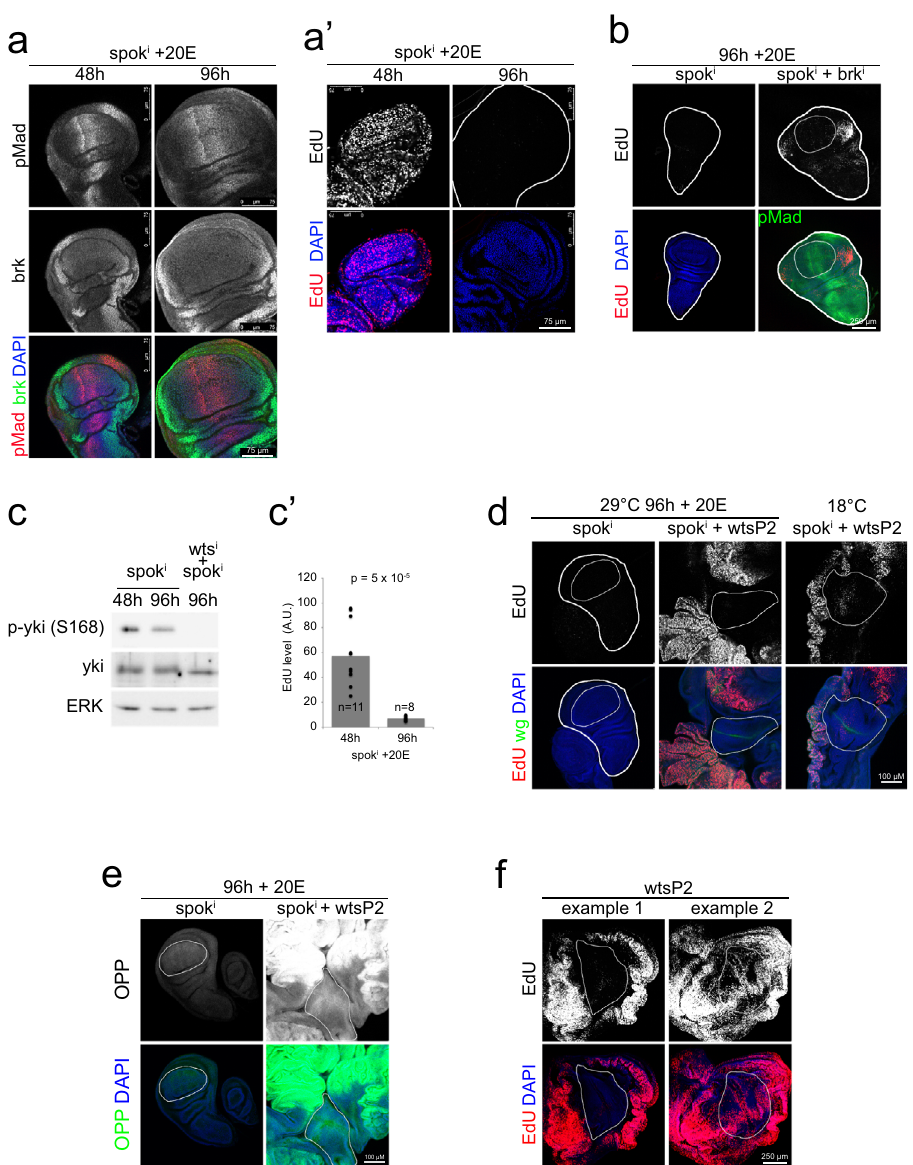
Fig. 3 For a given ecdysone concentration, proliferation in the wing pouch terminates successfully in the absence of warts or brinker . a – a ’ Dpp signaling activity, assayed by immunostaining Tub ts > spok i + 20E discs with pMad and brk antibodies ( a ), is similar in proliferating discs and in discs that have terminated proliferation ( a ’ ), 48 and 96 h after knockdown induction, respectively. Proliferation was assayed by EdU incorporation. n = 10 discs/condition × 3 biological replicates. b The wing pouch terminates proliferation also upon knockdown of brk . 96 h after knockdown induction, Tub ts > spok i + 20E discs have terminated proliferation, assayed by EdU incorporation. Most regions of discs with concomitant knockdown of brk ( spok i + brk i ) also stop proliferating with only the very lateral regions bypassing the stop. Thick white line outlines the disc, thin white line outlines the pouch. n = 10 discs/ condition × 3 biological replicates. c – c ’ Global yki activity does not drop in Tub ts > spok i + 20E discs when they terminate proliferation. c Phosphorylation of yki measured by immunoblotting lysates of wing discs 48 h or 96 h after knockdown induction from Tub ts > spok i + 20E or Tub ts > spok i + wts i + 20E animals. n = 40 discs/condition × 3 biological replicates. c ’ Proliferation was measured as a control via EdU incorporation. Representative of three biological replicates. P -value determined by t -test. d Wts loss of function in Tub ts > spok i + 20E discs ( spok i + wts P2 ) leads to overproliferation in proximal regions, assayed by EdU incorporation, whereas the pouch (white outline), identi fi ed by a wg expression stripe, terminates proliferation 96 h after knockdown induction and 20E feeding (29 °C 96 h + 20E). Without spok i knockdown (18 °C spok i + wts P2 ) wts P2 discs also stop proliferating in the pouch (white outline) with overproliferating proximal regions. n = 10 discs/condition × 3 biological replicates. e The wing pouch (white outline) of spok i + wts P2 discs has reduced growth compared to proximal regions, assayed by OPP incorporation, 96 h after knockdown induction and 20E feeding. n = 6 discs. f The wing pouch of wts P2 (in WT background) discs can stop proliferating in L3 larvae. A range of phenotypes is observed, from example 1, where the pouch is completely EdU negative, to example 2, where the compartment boundaries are still EdU positive and the quadrants are EdU negative. n = 10 discs/condition × 3 biological